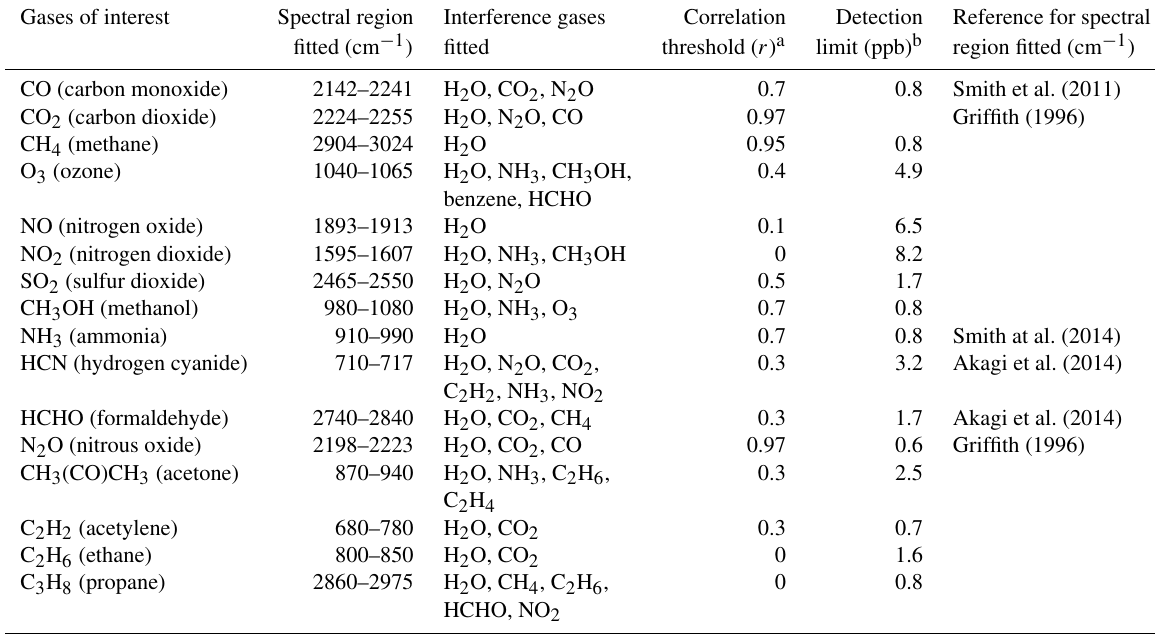
Table 1. Regions of long-path FTIR spectra used to retrieve mixing ratios of target gases in this study. Gases of